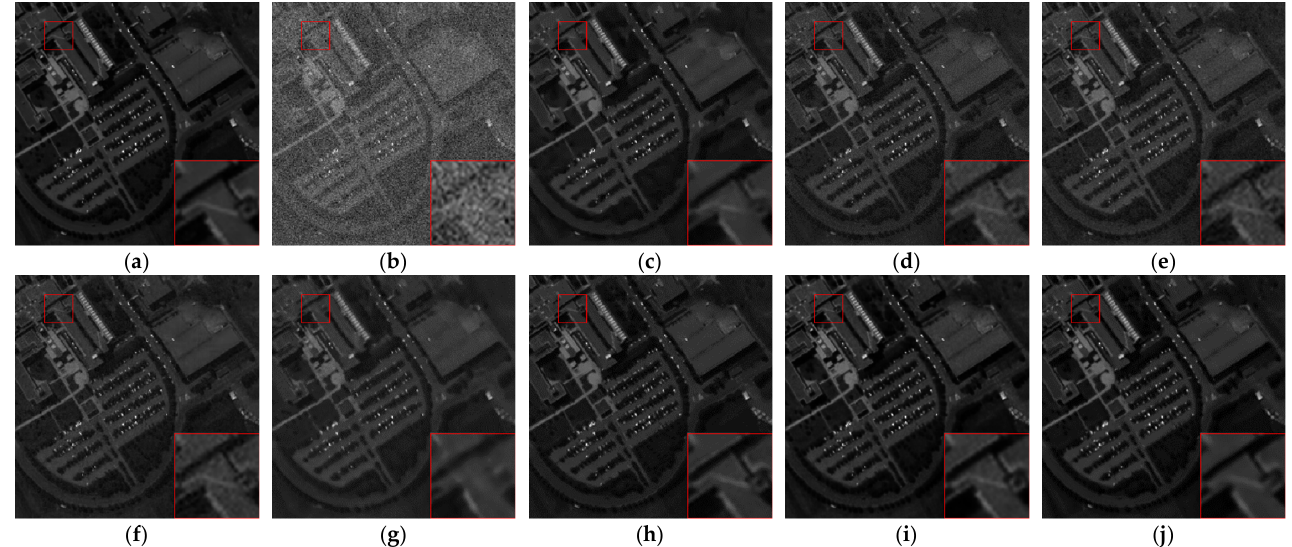
Figure 5. Case 1 2 —Denoising results of different algorithms in band 7: ( a ) clean band; ( b ) noisy band; ( c ) BM4D; ( d ) LRMR; ( e ) HyRes; ( f ) L1HyMixDe; ( g ) DHP-2D; ( h ) SIP; ( i ) SURE-CNN; and ( j ) 3S-HSID.